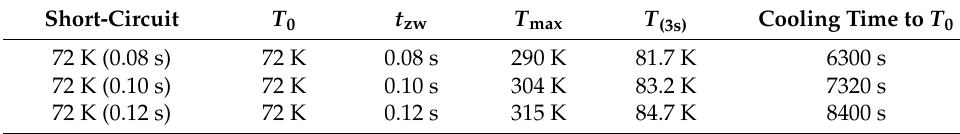
Table 4. Maximum temperature T max and end temperature (after 3 s) T (3s) of the limiter acc. Figure 12 and cooling time to T 0 . T 0 —initial temperature, t zw —short-circuit